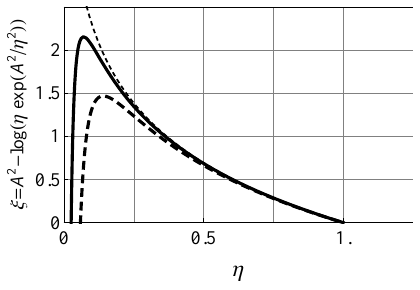
(cid:16) (cid:16) (cid:17)(cid:17) η exp A 2 /η 2 with varying Figure 4. Illustration of the two real branches of Lambert’s W func- tion. Full line gives W 0 (x) , dashed line W − 1 (x) . There is a branch- cut at x = − 1 / exp ( 1 ) , marked by ◦